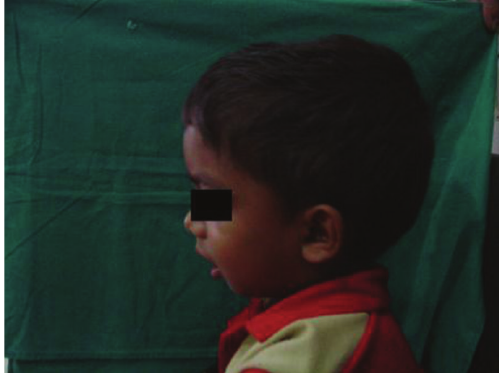
Figure 1: Clinical photograph of the patient showing brachy- cephalic head and frontal bossing.